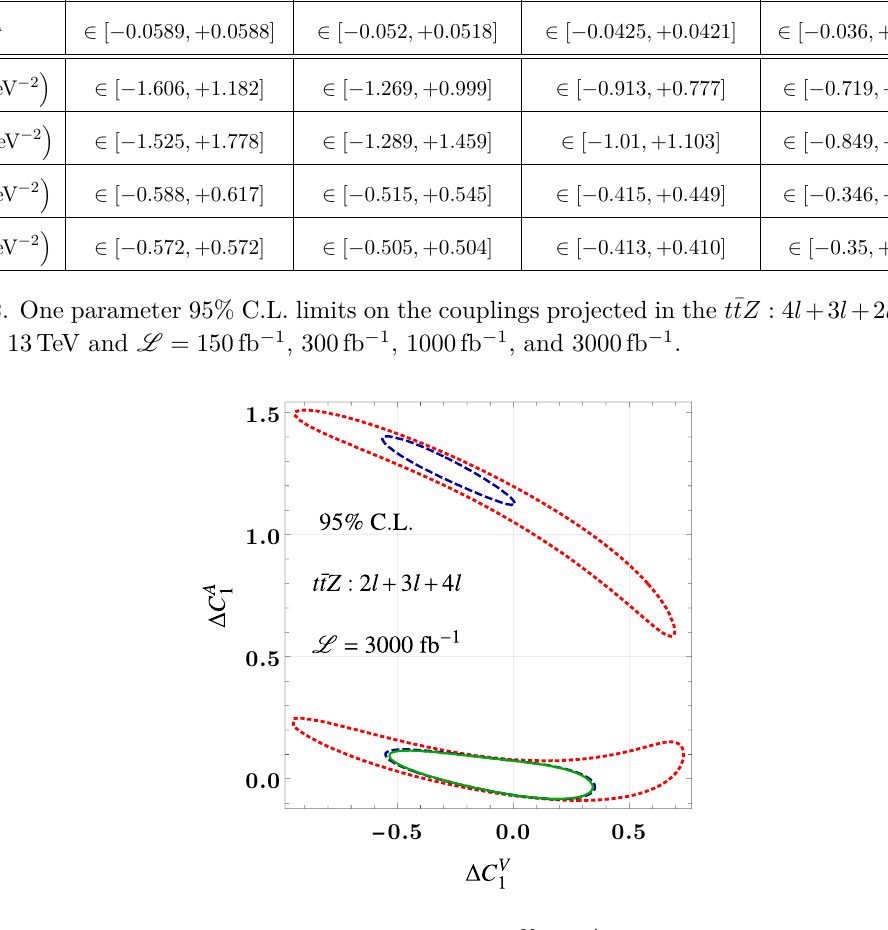
Figure 9 . The two-parameter 95% C.L. contours in ∆ C V i.e., t ¯ tZ : 2 l + 3 l + 4 l channels for legends are the same as in figure 8.